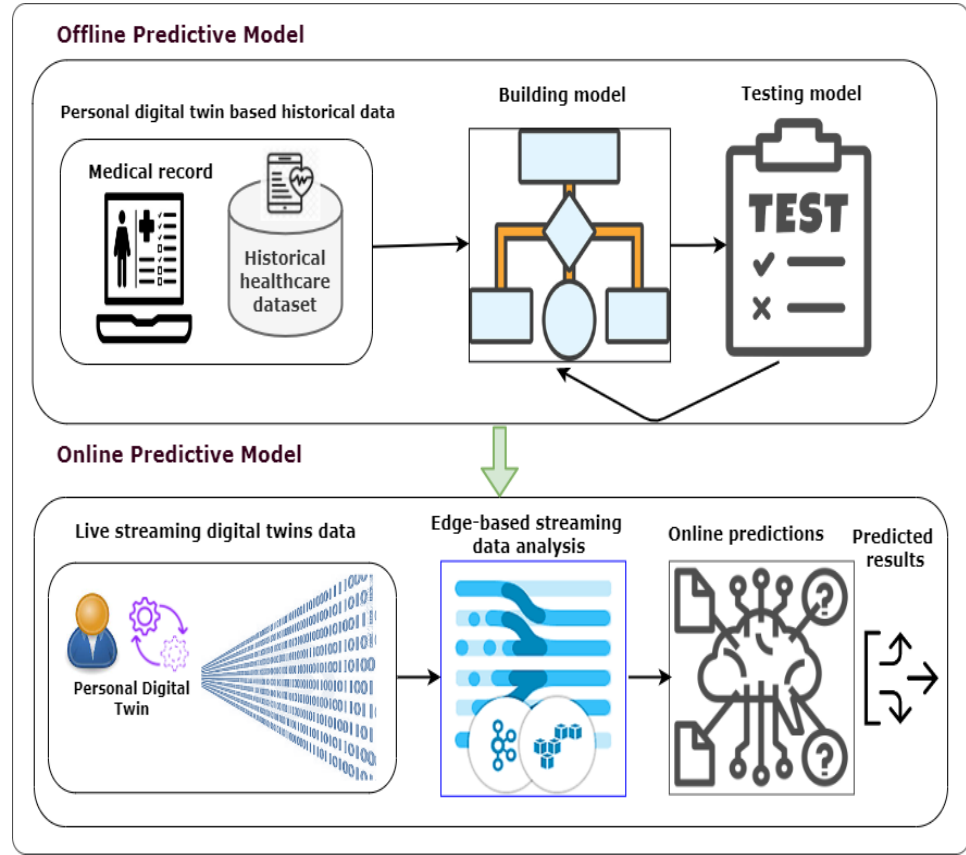
Figure 9. The workflow of building a predictive model based on a personal digital